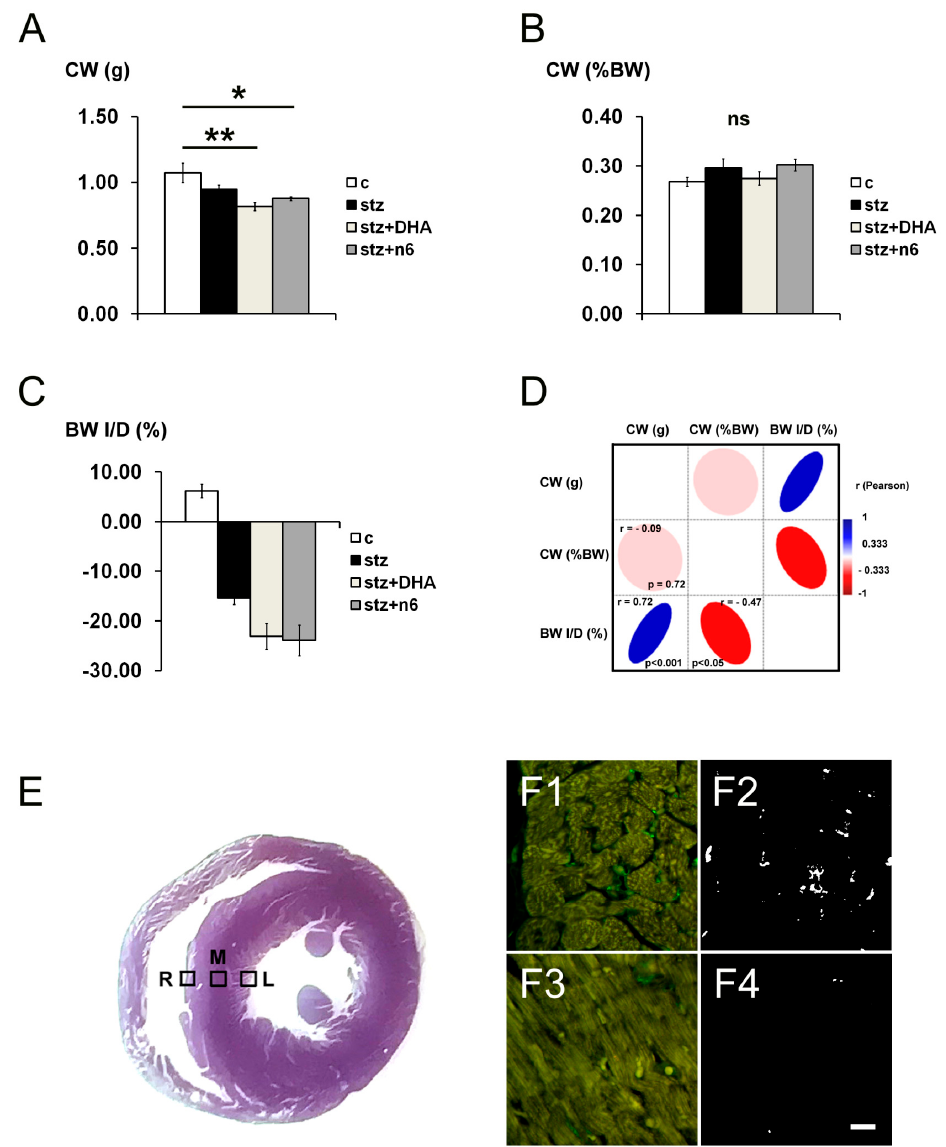
Figure 1. Cardiac weight, body weight changes and sampling of visual fields. ( A ) Cardiac weight (CW; g) of rats in di ff erent experimental groups: c—control group; stz—diabetic group fed standard diet (both diets n6 / n3 ratio ≈ 7); stz + DHA—diabetic group supplemented with n3 polyunsaturated fatty acid (PUFA) (2.5% of fish oil, containing 16% eicosapentaenoic acid—EPA and 19% docosahexaenoic acid—DHA; n6 / n3 ratio of ≈ 1); stz + n6—Diabetic group fed with diet that contained 2.5% sunflower oil (n6 / n3 ratio ≈ 60). *— p < 0.05; **— p < 0.01 di ff erence between indicated groups. ( B ) Cardiac weight expressed as percentage of body weight (%BW). No significant di ff erence in CW expressed as %BW was found (ns). ( C ) Body weight increase or decrease (BW I / D) expressed as % of the initial weight. ( D ) Correlation analysis between CW (g), CW (%BW) and BW I / D (%)—Pearson’s coe ffi cient of correlation (r). ( E ) section through the ventricles of the rat heart (non-related specimen), showing example of positioning of the visual fields for analysis—M—Intramural (Mid.) part of the cardiac septum; R—Right subendocardial area of the septum; L—Left subendocardial area of the septum. ( F ) Representative photomicrographs showing comparison of the density of fibers in the right side of the subendocardial area of the cardiac septum (F1 and F2) and Mid. area (F3 and F4) of the same animal, stained for general neuronal marker Protein g Product (PgP) 9.5 (green). Tresholded figures F2 (tresholded from F1) and F4 (tresholded from F3). Substantially lower density of fibers was found in M, in comparison to R (or L—Not shown). Scale-bar = 20 µ